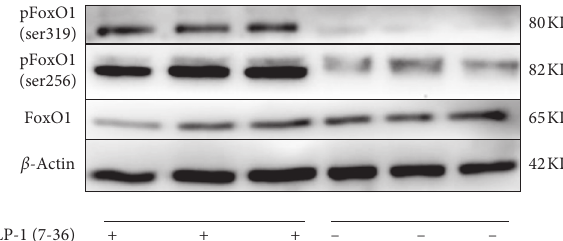
Figure 4: GLP-1 (7-36) induced phosphorylation of FoxO1 in PCOS ovarian MGCs. The isolated PCOS mice ovarian GCs were pretreated in the presence or absence of 100nM GLP-1 (7-36) to detect FoxO1, pFoxO1 (Ser 256), and pFoxO1 (ser 391) using their specific antibodies by the Western blot analysis. The experiment was repeated thrice.